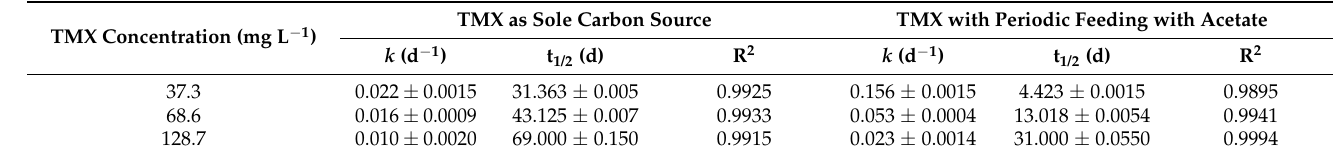
Table 2. First-order rate constant ( k ) and half-life (t 1/2 ) for degradation of TMX at different concentra- tions by L. portucalensis